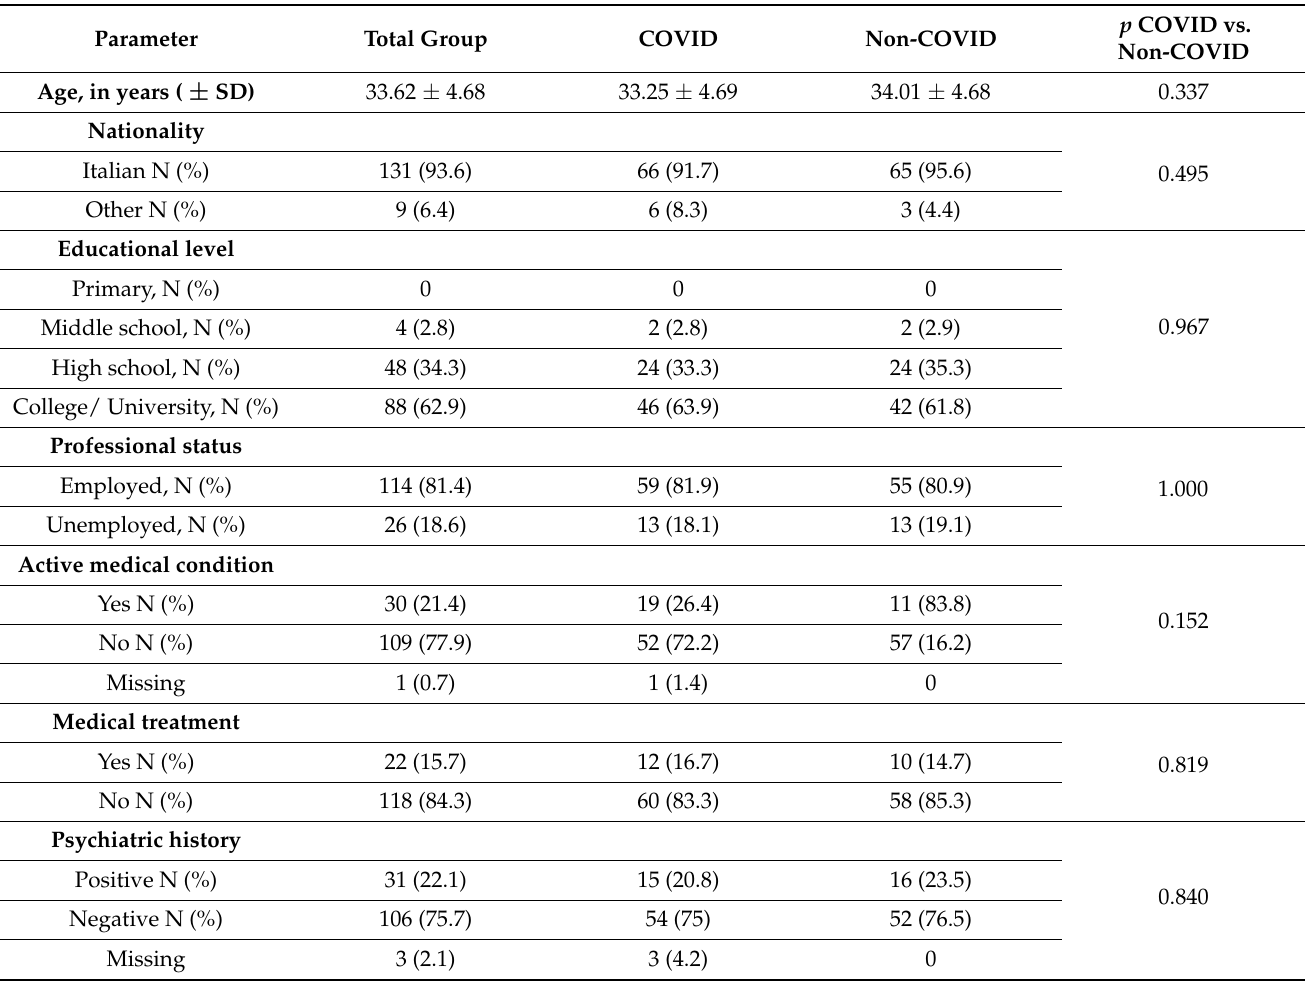
Table 1. Socio-demographic and clinical characteristics of the COVID (N = 72) and Non-COVID (N = 68) samples ( p values reflect Student’s t for means and SDs, and χ 2 for N and %).